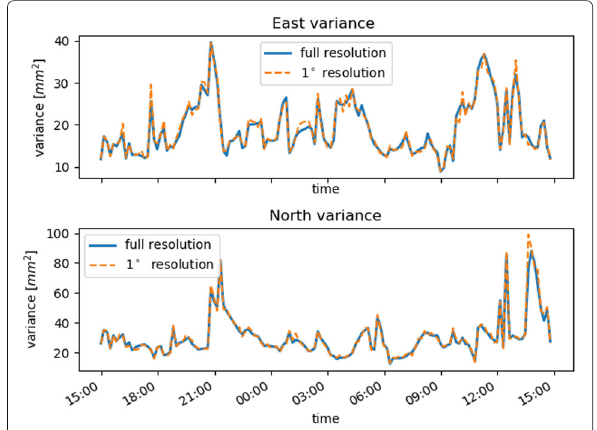
Fig. 17 RTK localization error variance, computed with Eq. (55), for non-rounded and rounded to 1 ◦ satellites coordinates ( az , el ) in Loc1